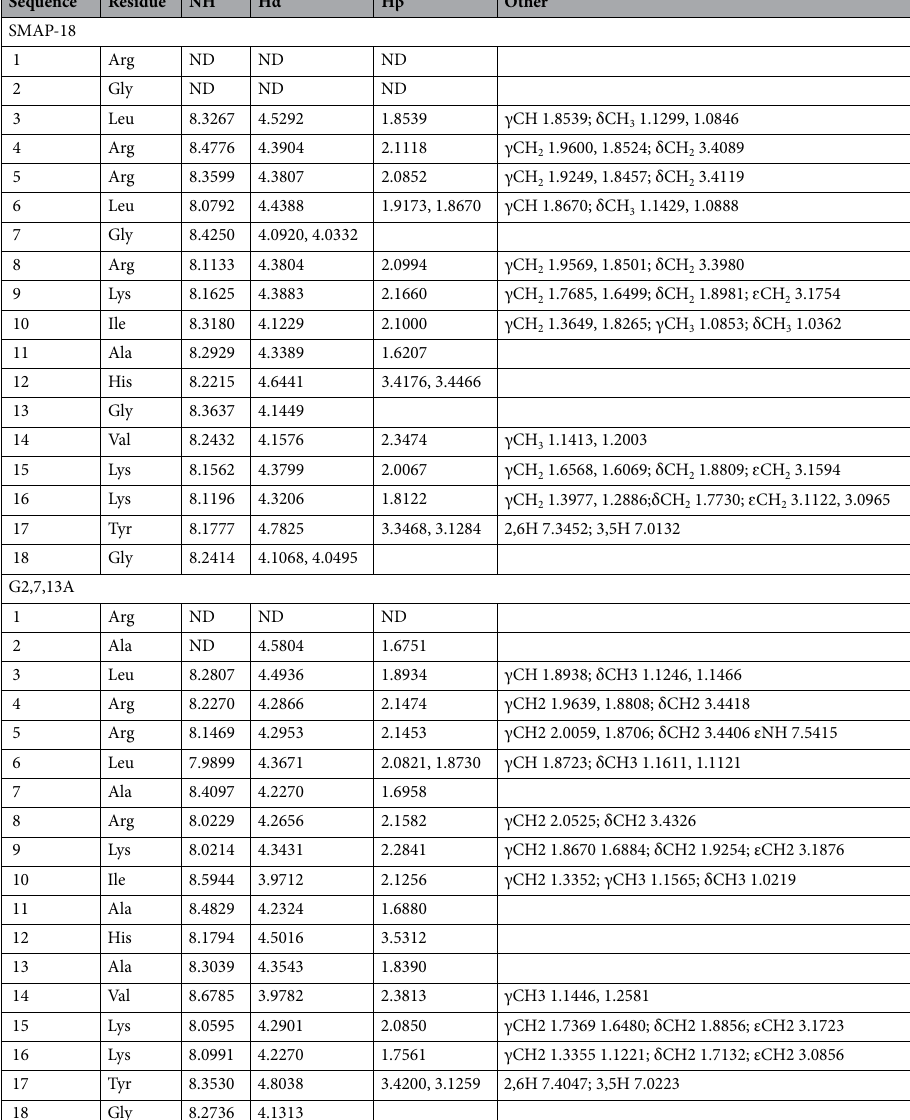
Table 3. NMR proton chemical shifts of SMAP-18 and